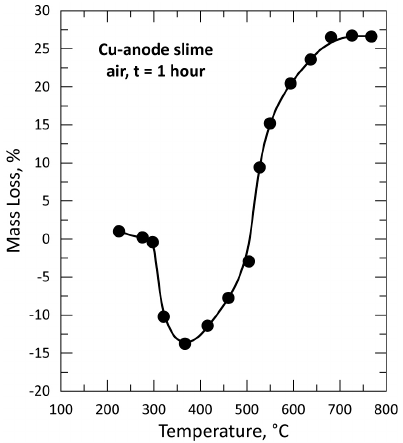
Figure 4. Evolution of the mass loss of the sample versus temperature during treatment of CAS in air for 1 h.